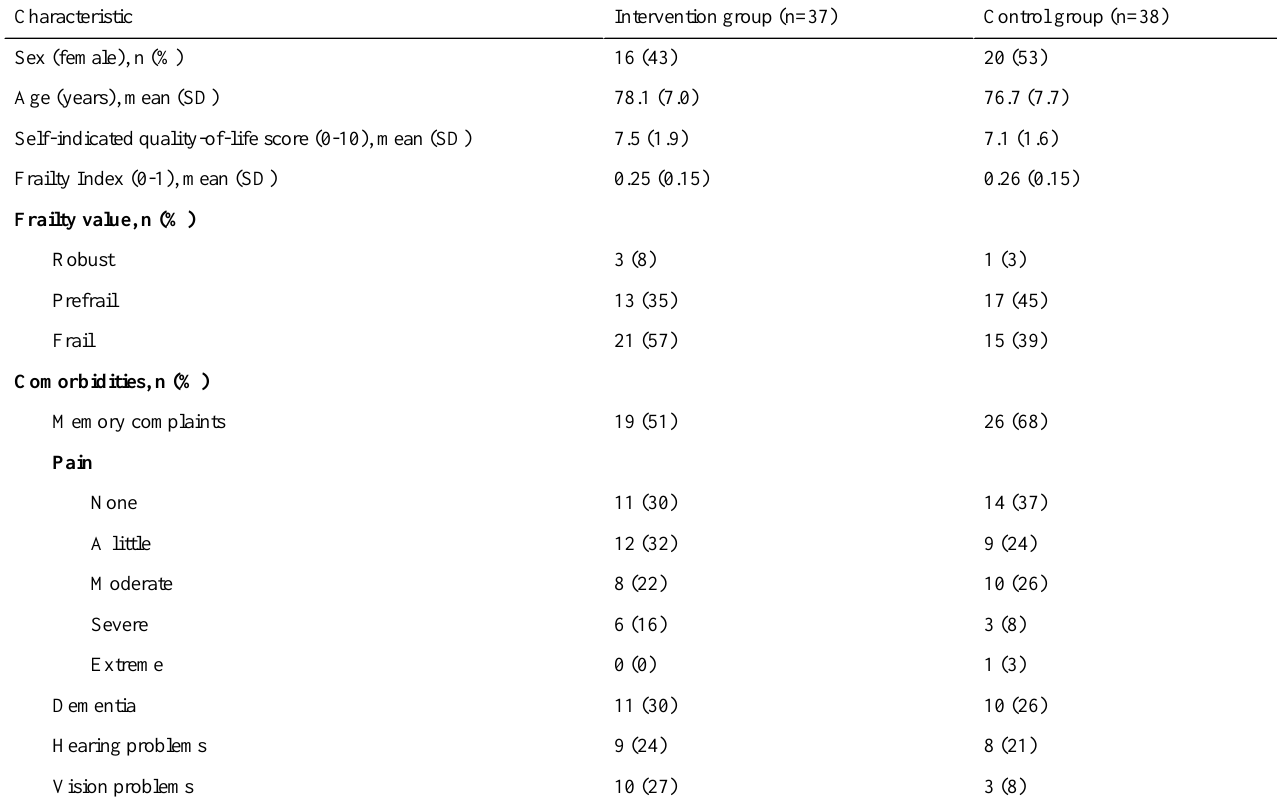
Table 1. Baseline characteristics of the study population (N=75).